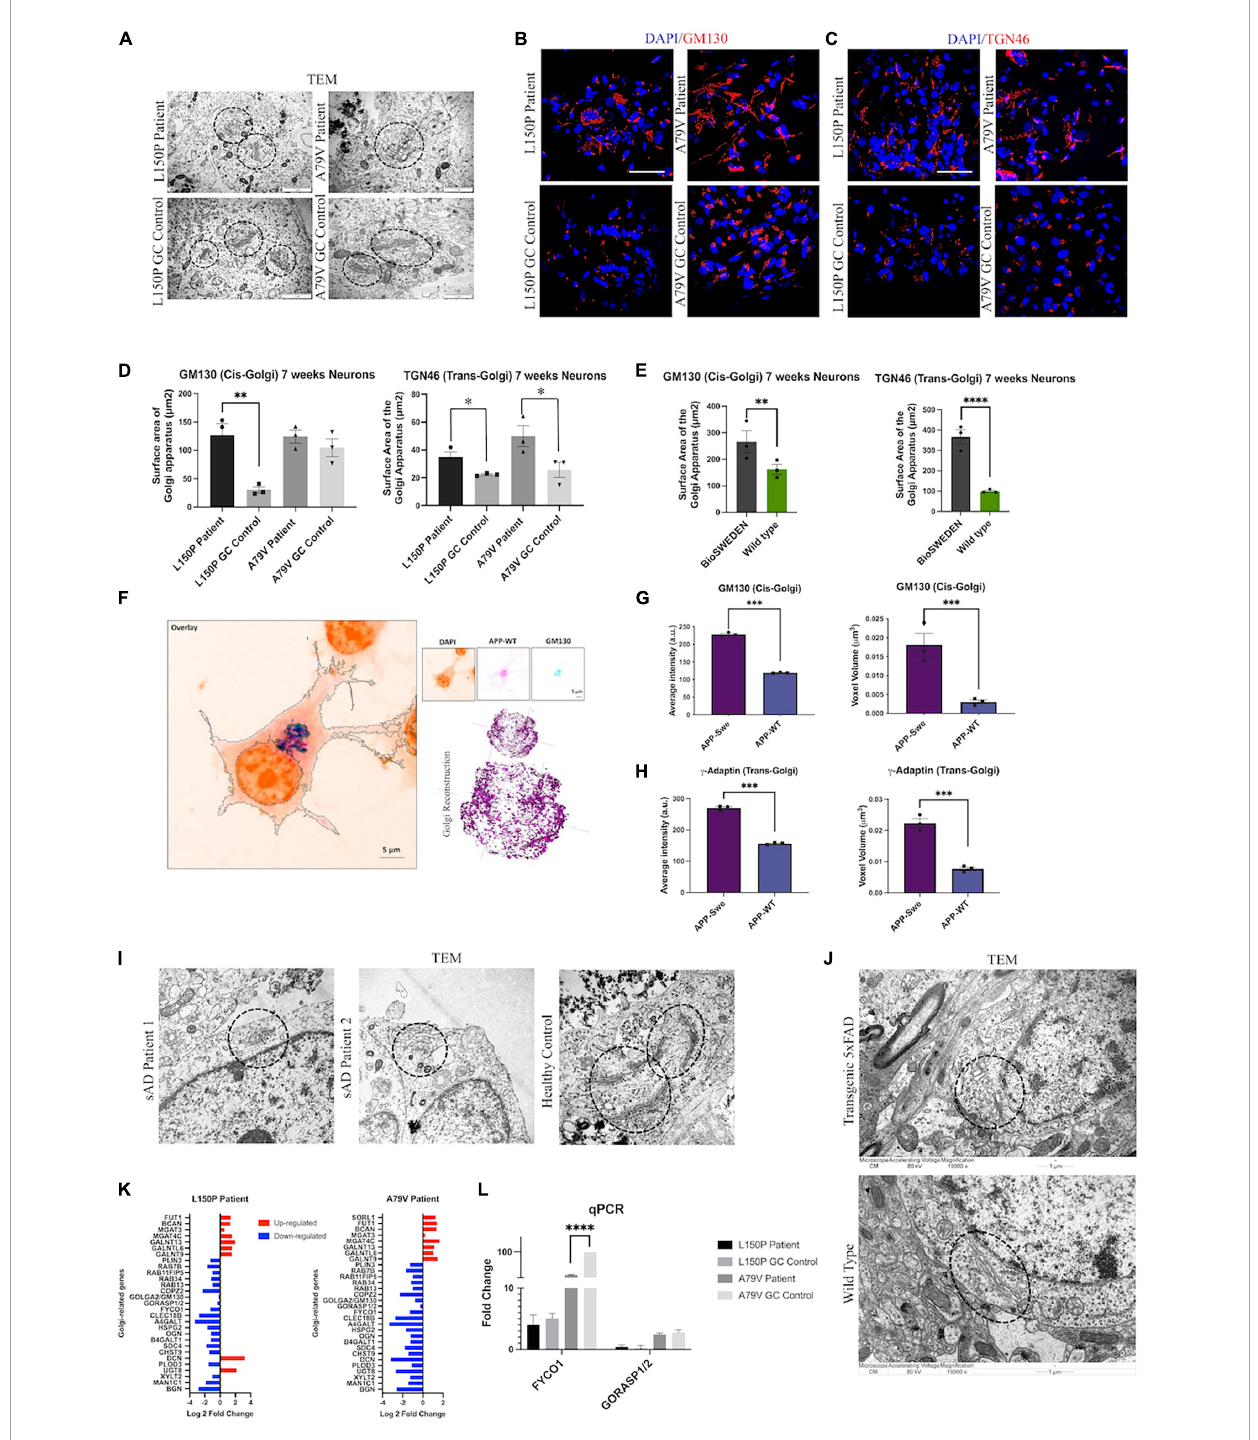
FIGURE3 Golgi fragmentation is a universal phenotype in AD. (A) TEM evaluation of Golgi morphology (circled). Scale bar 1 µ m. (B) Representative ICC images of cis-Golgi marker GM130. Scale bar 50 µ m. (C) Representative ICC images of trans-Golgi marker TGN46. Scale bar 50 µ m. (D) Quantitative assessment of cis- and trans-Golgi surface area in L150P and A79V hiPSC derived neurons. (E) Quantitative assessment of cis- and trans-Golgi surface area in K3P53 and BioSweden hiPSC derived neurons. (F) Representative images of cis-Golgi marker GM130 in APP-WT/Swe transfected N2A cells obtained using Airyscan super resolution microscopy. Scale bar 5 µ m. (G) Quantitative assessment of biophysical (intensity) and morphological (voxel volume) traits of cis-Golgi in APP-WT/Swe transfected N2A cells. (H) Quantification of biophysical (intensity) and morphological (volume) traits of trans-Golgi in APP-WT/Swe transfected N2A cells. (I) TEM evaluation of dilated Golgi morphology (circled) in hiPSC derived neurons derived from sporadic AD (sAD) patients. Scale bar 1 µ m. (J) TEM evaluation of Golgi fragmentation (circled) in a transgenic 5xFAD mouse model. (K) Top significantly differentially expressed genes associated with the Golgi apparatus. (L) qPCR validation of key differentially expressed -Golgi-associated genes identified by RNA-seq analysis. Results are displayed as mean ± standard error of the mean (SEM) from three replicates. Significance levels are indicated by ∗ p < 0.05, ∗∗ p < 0.01, ∗∗∗ p < 0.001, and ∗∗∗∗ p <